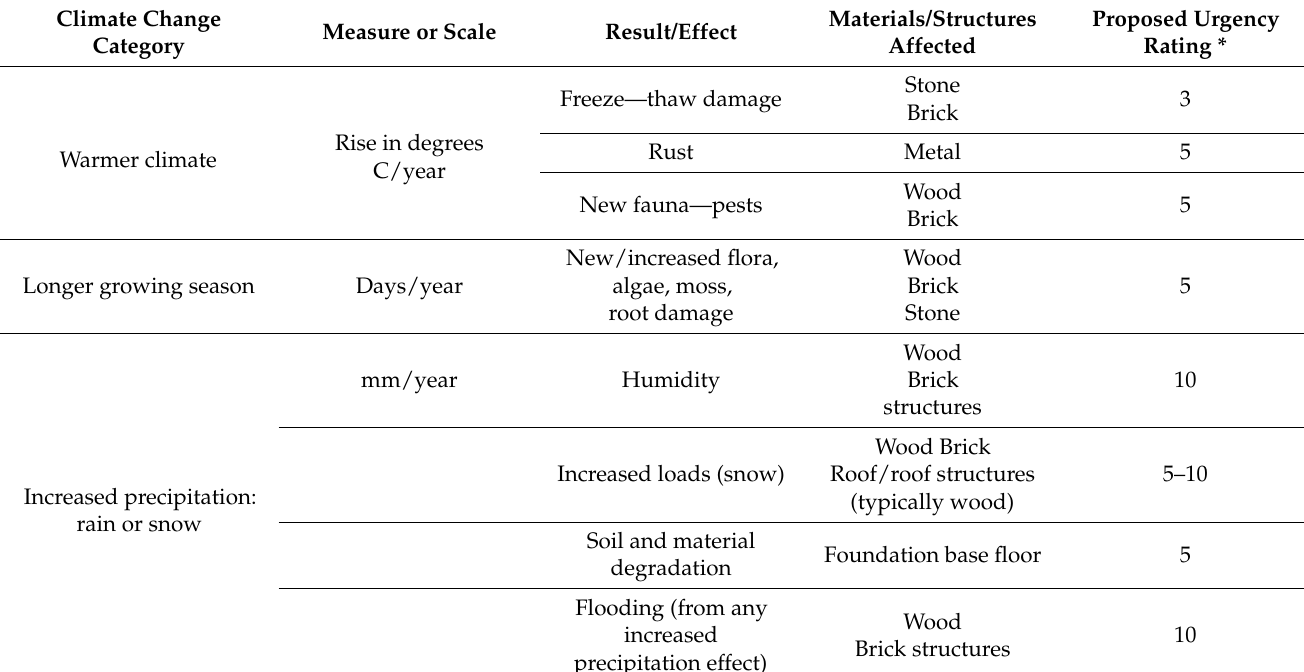
Table 1. Table demonstrating causes, results, and proposed level of urgency for acting in case studies in Southern Finland, in which the urgency rating * is classified as follows: 1—A mild or minor perceivable long-term effect (100 years or more), 3—A major perceivable long-term effect (50–100 years), 5—A mild or minor perceivable short- to mid-term effect (1–50 years), and 10—A major short- to mid-term effect (adapted from Carroll & Aarrevaara 2018